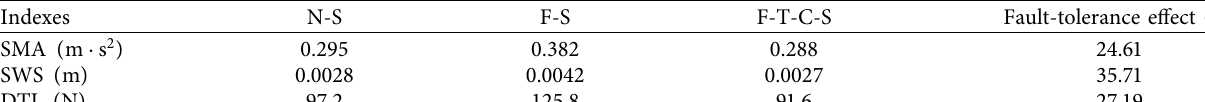
Table 7: The output RMS values in time domain under bumped road.